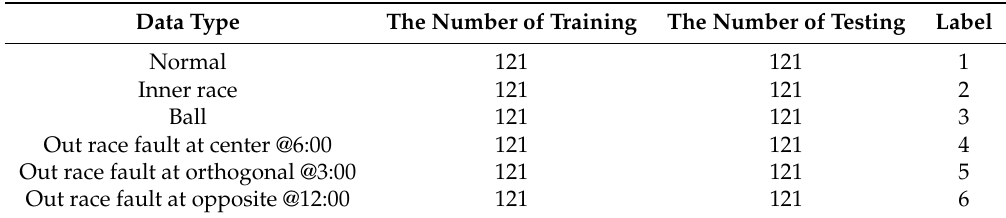
Table 2. Description of the data